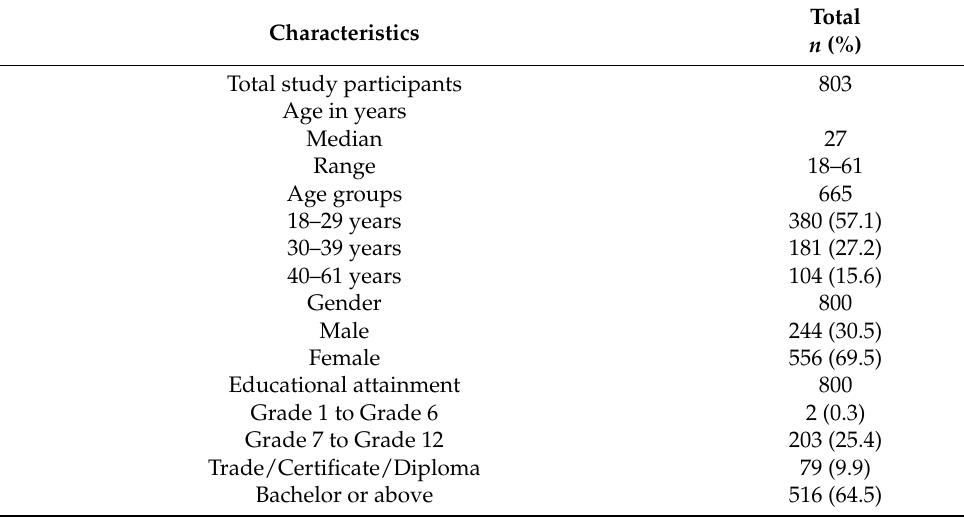
Table 1. Characteristics of the study